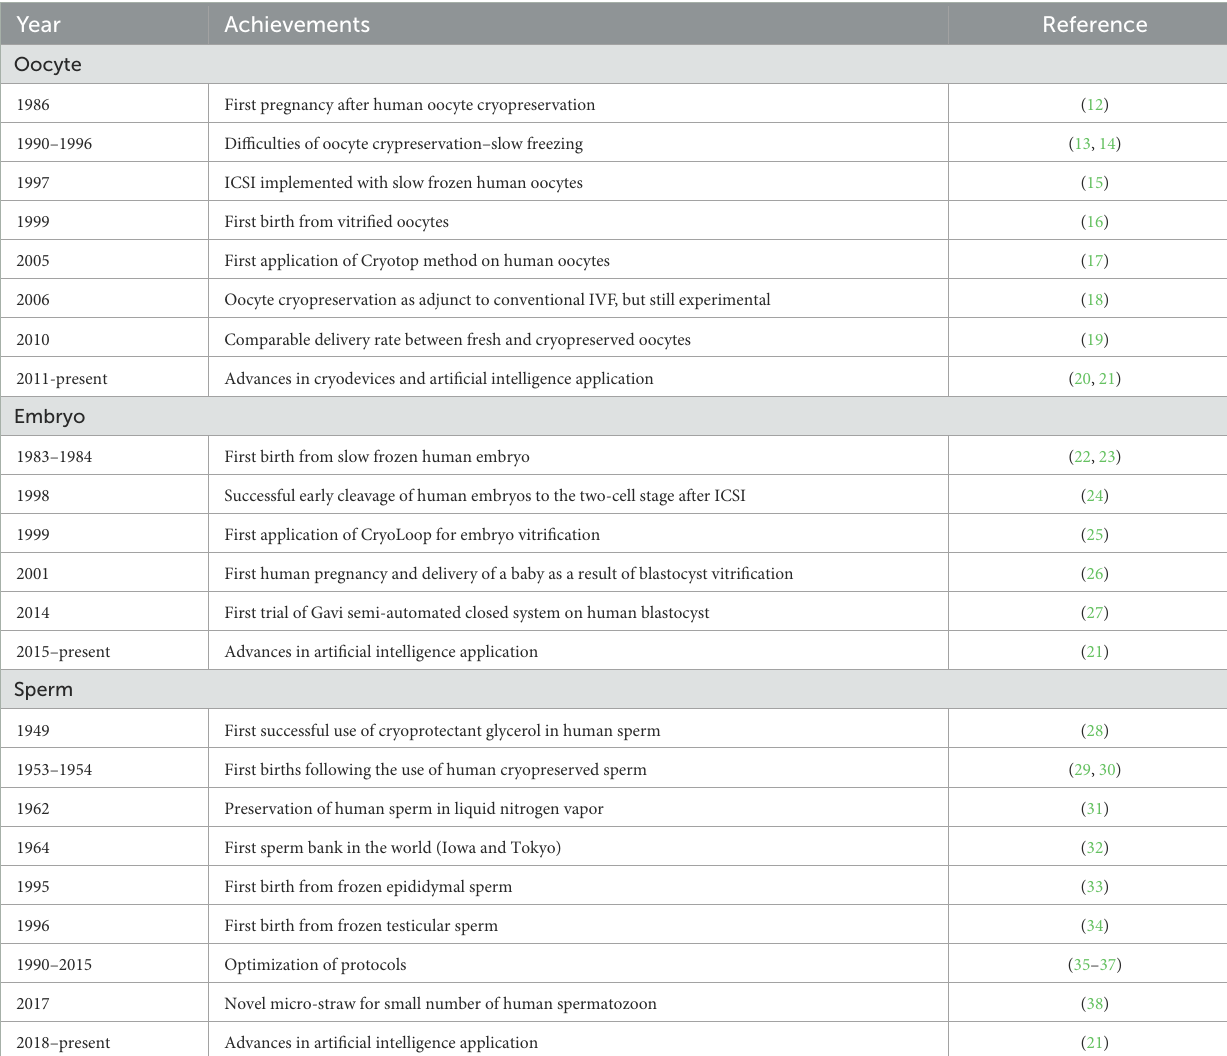
TABLE 1 History of the improvement of oocyte, sperm and embryo